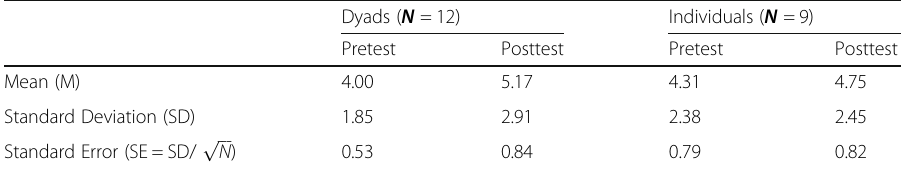
Table 3 Descriptive statistics on the pretest and posttest scores of dyads and individuals